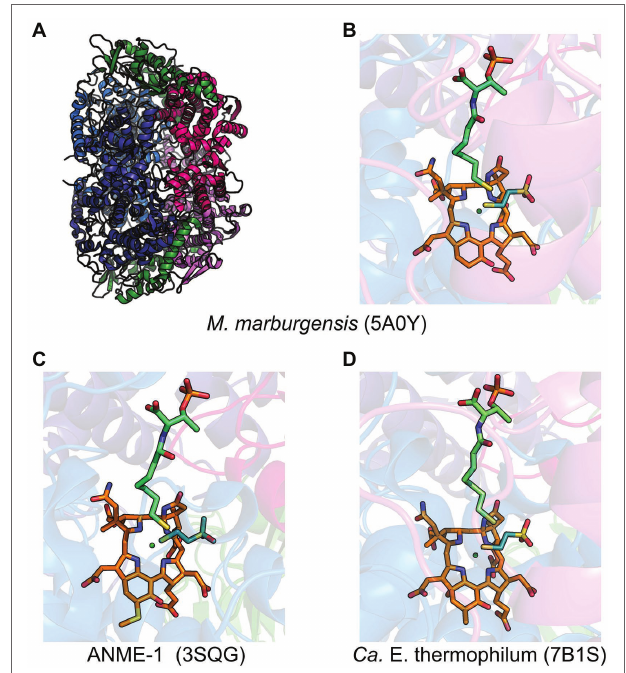
FIGURE 2 | Representative crystal structures of MCRs and ECR. (A) MCR from M. marburgensis and (B) the associated active site with F 430 , HS-CoB, and HS-CoM. (C) Black Sea mat ANME-1 MCR active site with 17 2 -methylthio-F 430 , HS-CoB, and HS-CoM. (D) Ca. E. thermophilum ECR active site with dimethyl-F 430 , HS-CoB, and HS-CoM. α subunits are shown in marine and deep blue, β subunits in hot pink and violet, γ subunits in forest green, F 430 in orange, coenzyme M in deep teal, and coenzyme B in lime